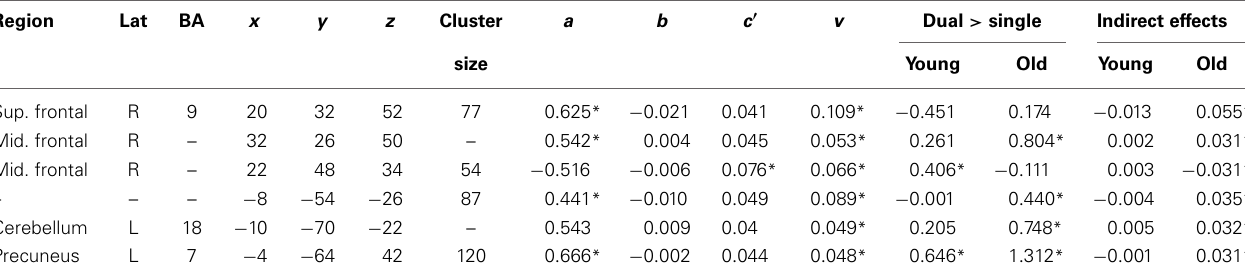
Table 2 | Moderated-mediation analysis